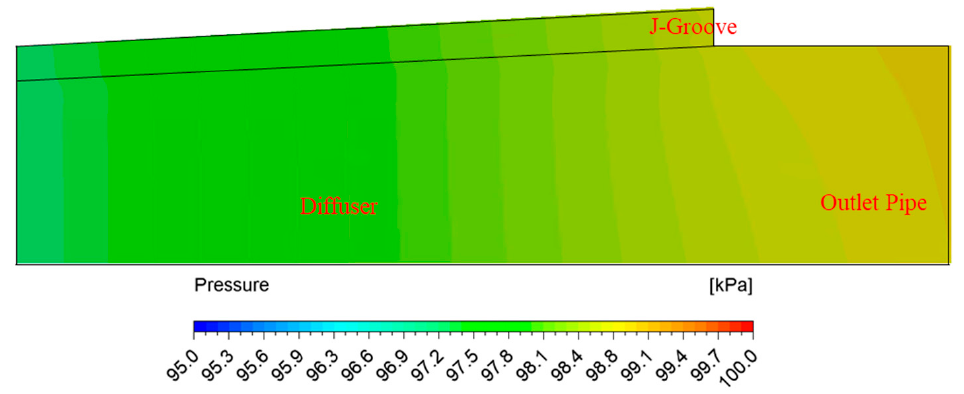
Figure 17. Pressure contours in the AJP model with J-Groove at q = 0.5.